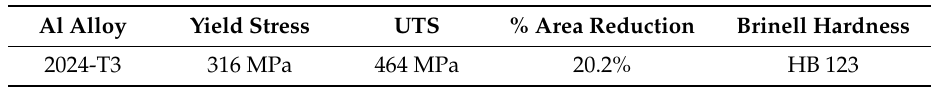
Table 2. Mechanical properties of the aluminum alloy 2024-T3, as provided by the manufacturer (Kaiser Aluminum, Spokane, WA,